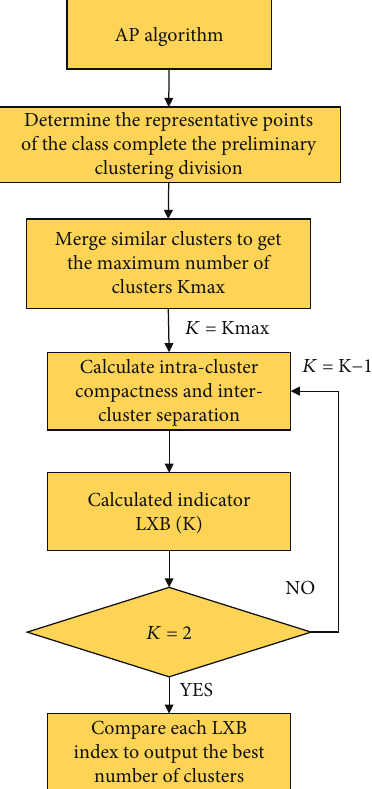
Figure 2: Clustering quality evaluation